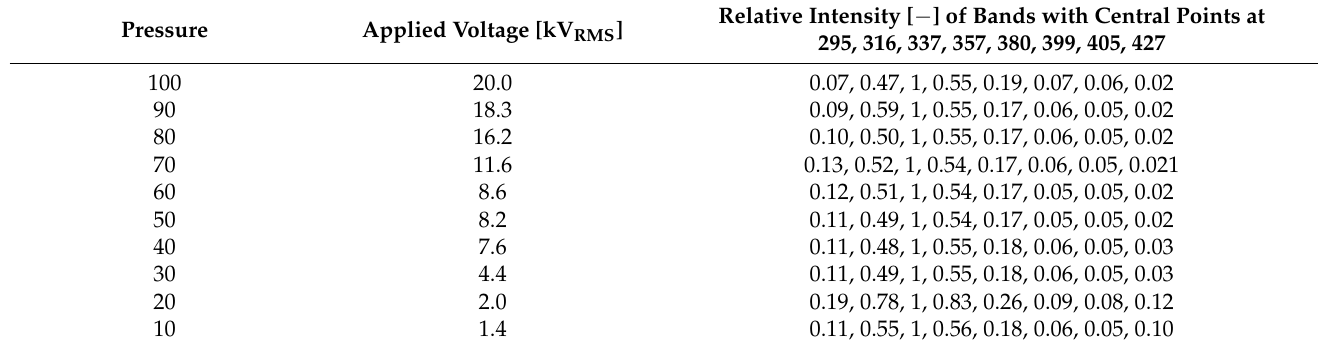
Table 3. Electric arcs. Experimental conditions using a needle-plane gap (diameter = 1.0 mm, gap = 30 mm), main spectral bands and their relative